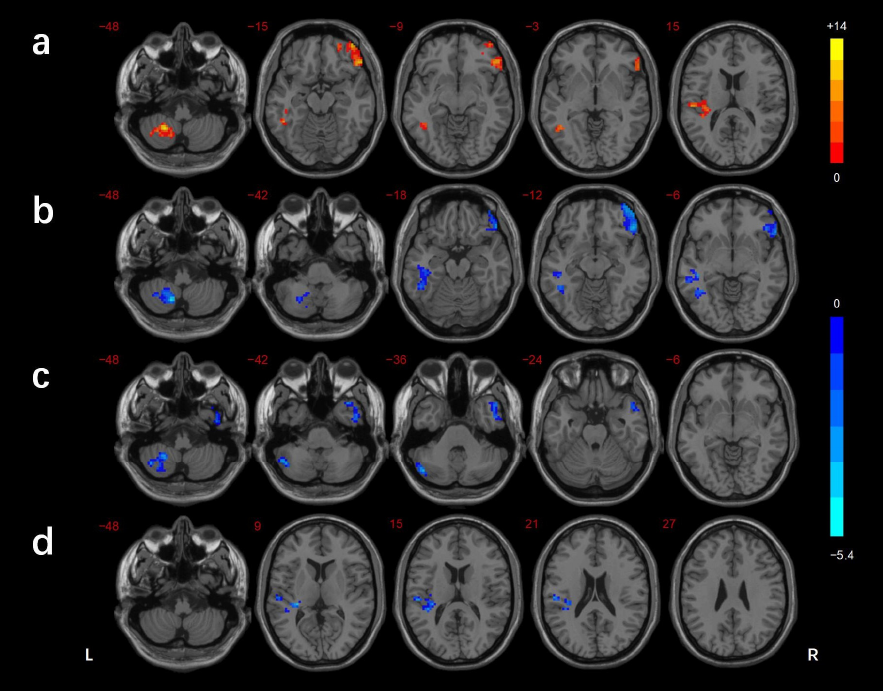
Figure 3. Comparison of long-range FCDs among groups (GRF corrected p < 0.005, cluster level p < 0.05). ( a ) Significant difference in long-range FCDs among three groups. ( b ) Significant difference in long-range FCDs between the DMCI and HC groups. ( c ) Significant difference in long-range FCDs between the DMCN and HC groups. ( d ) Significant difference in long-range FCDs between the DMCI and DMCN groups. The color scale denotes the t -value. L, left; R, right. Table 3. Regions of abnormal short-range FCDs among the three groups.